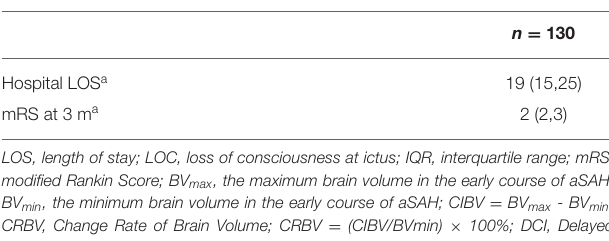
TABLE 1 | Study patient